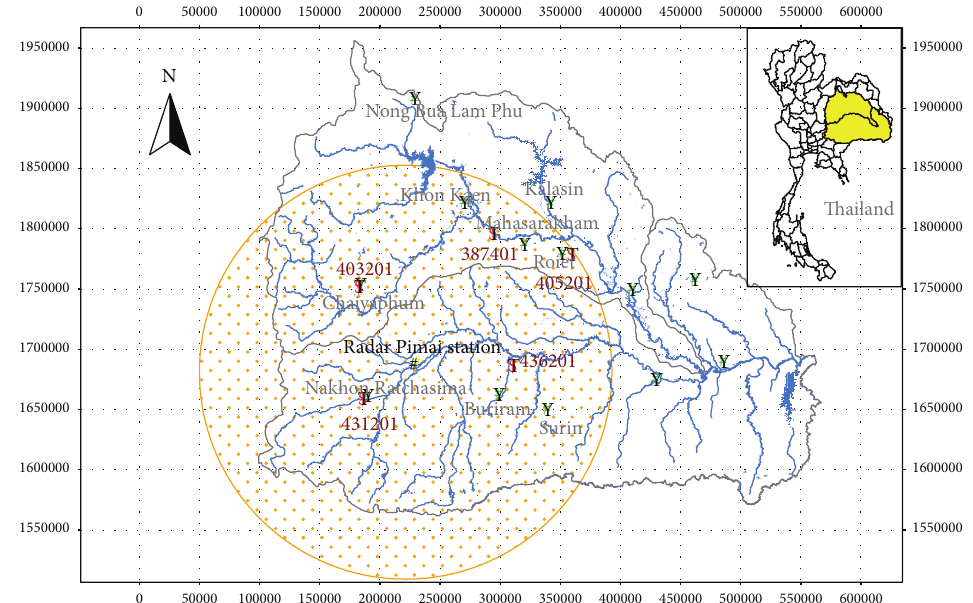
Figure 1: Locations of the five meteorological stations.